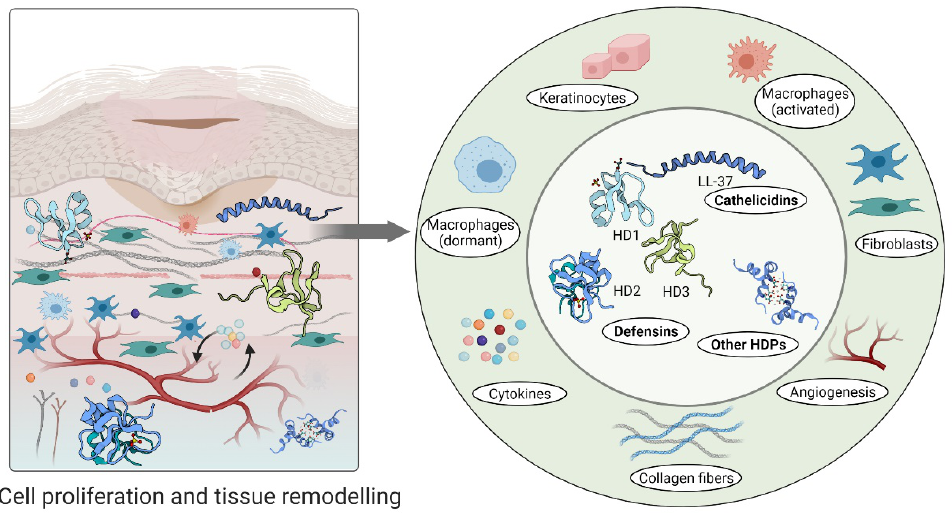
Figure 4. Host defence peptides involved in later stages of wound healing to assist skin